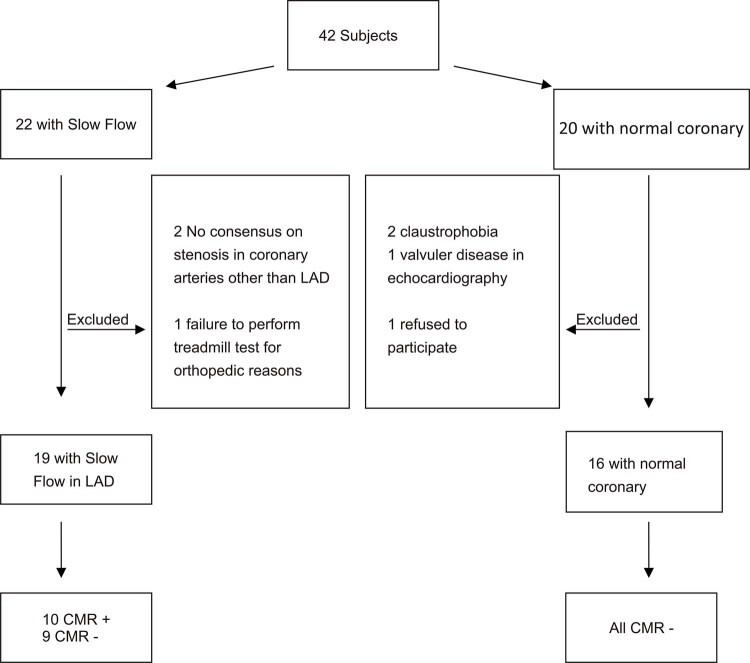
–
Patient selection. CMR: cardiac magnetic resonance imaging.